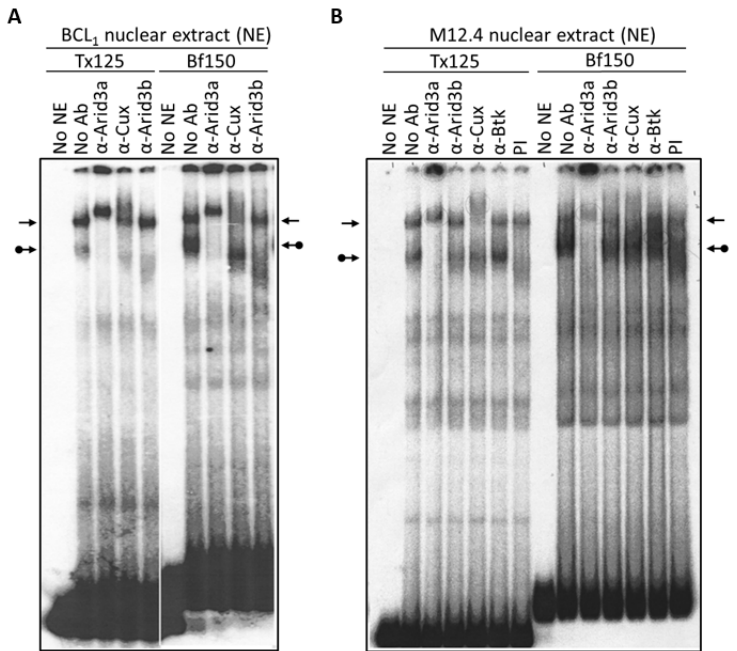
Figure 2. NF- μ NR and Arid3a bind to V H 1 promoter-associated MARs Tx125 and Bf150 with different affinities. BCL 1 ( A ) and M12.4 ( B ) nuclear extracts were prepared and subjected to EMSA using